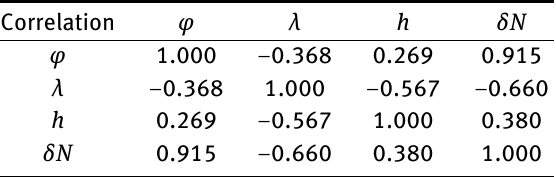
Table 2: Correlation Matrix (Determinant = 0.023) Correlation